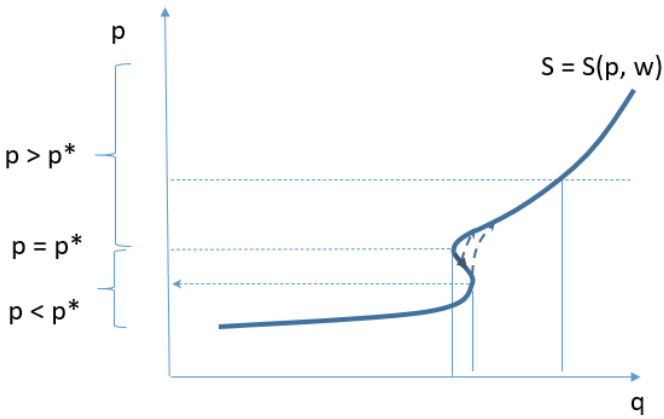
Figure 1. Supply curve under liquidity constraints. Source: Authors. Note: p * is a benchmark price. When the price declines to a level below p *, the liquidity constraint is binding and the supply will increase. When the price further declines, the supply will increase further to ensure a certain minimum cash flow. Beyond a certain point, the firm will sharply diminish its supply and/or close business. Moreover, when the price increases (given p < p *), it will not follow the flat supply curve and decrease its supply with increasing prices, but it will rather follow a route according to the dotted lines and directly lead to increases in supply. This causes an asymmetric price response pattern.